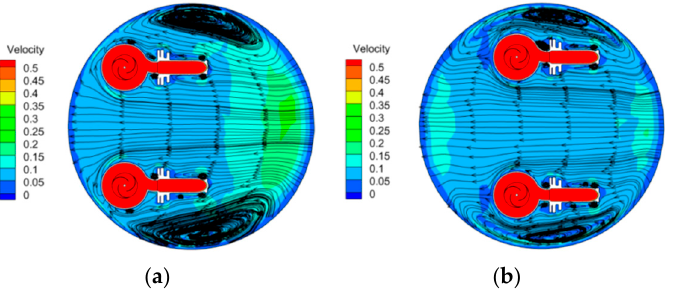
Figure 11. Streamline and velocity distribution of N2 section before and after optimization. ( a ) Before optimization. ( b ) After optimization.